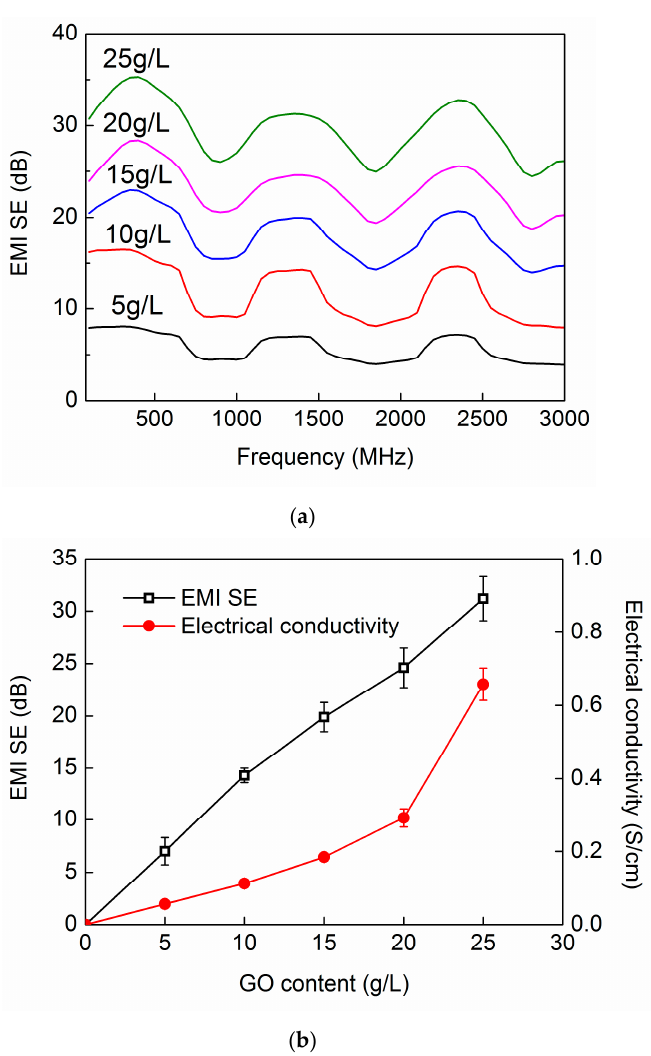
Figure 7. Electromagnetic properties of composites with various GE content in coating agent. ( a ) Variation of EMI SE with incident frequency from 100 to 3000 MHz and ( b ) EMI SE at 1400 MHz and electrical conductivity.